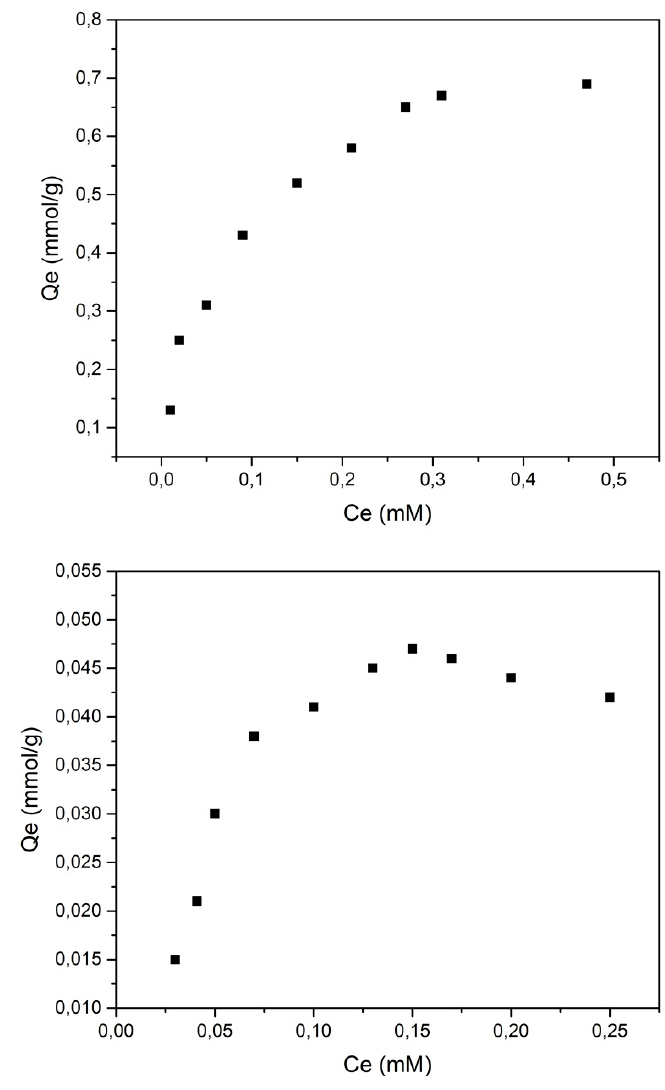
Figure 8. Sorption isotherms for 4-chlorophenoxyacetic acid (4-CPA) ( upper ) and Sorption isotherms for 4-chlorophenoxyacetic acid (4-CPA) ( upper ) and 2,3,4,6- 2,3,4,6-tetrachlorophenol (TCF) ( lower ). tetrachlorophenol (TCF) ( lower